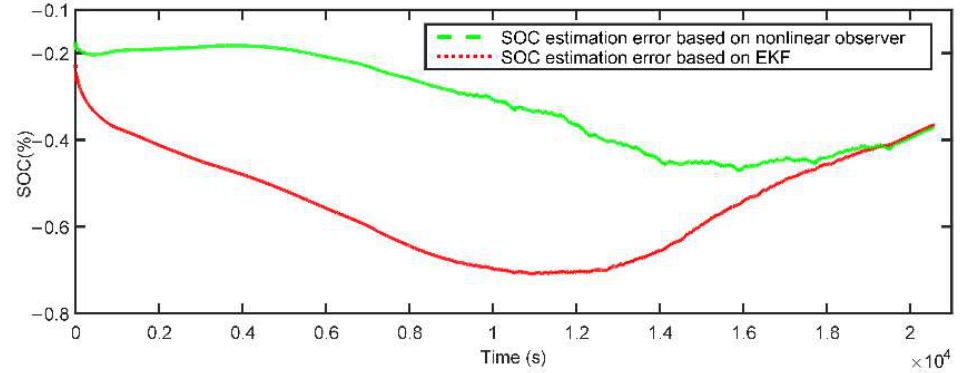
Figure 25. Comparison of SOC estimation based on non-linear observer and EKF in dynamic con- dition test 3.